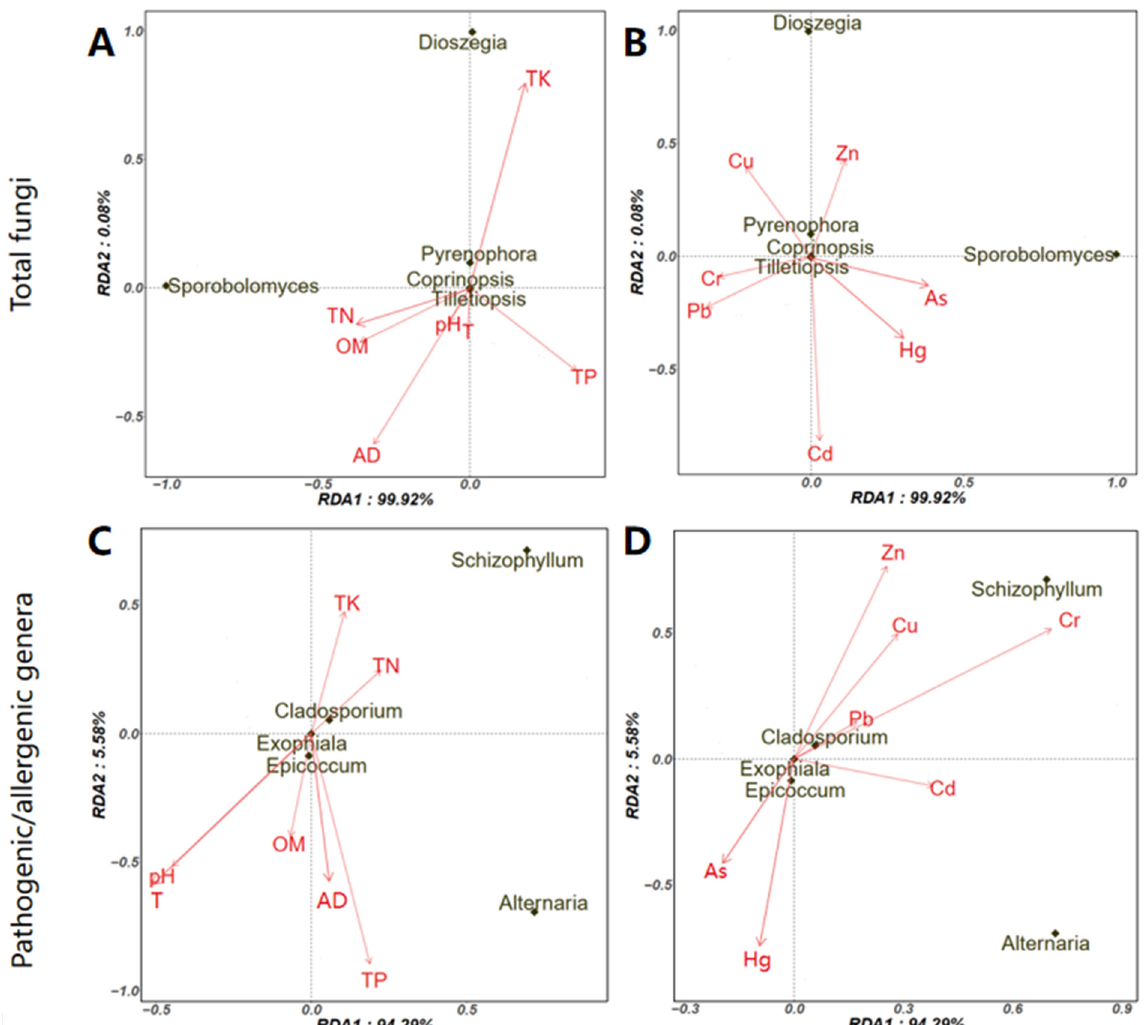
Figure 8. Factors associated with the aerosolization behavior of fungal genera using redundancy analysis. ( A ), physicochemical parameters on top 5 fungi with the highest log BI; ( B ), Specific heavy metal on top 5 fungi with the highest log BI; ( C ), physicochemical parameters on top 5 pathogenic/allergenic genera with the highest log BI; ( D ), Specific heavy metal on top 5 pathogenic/allergenic genera with highest log BI.